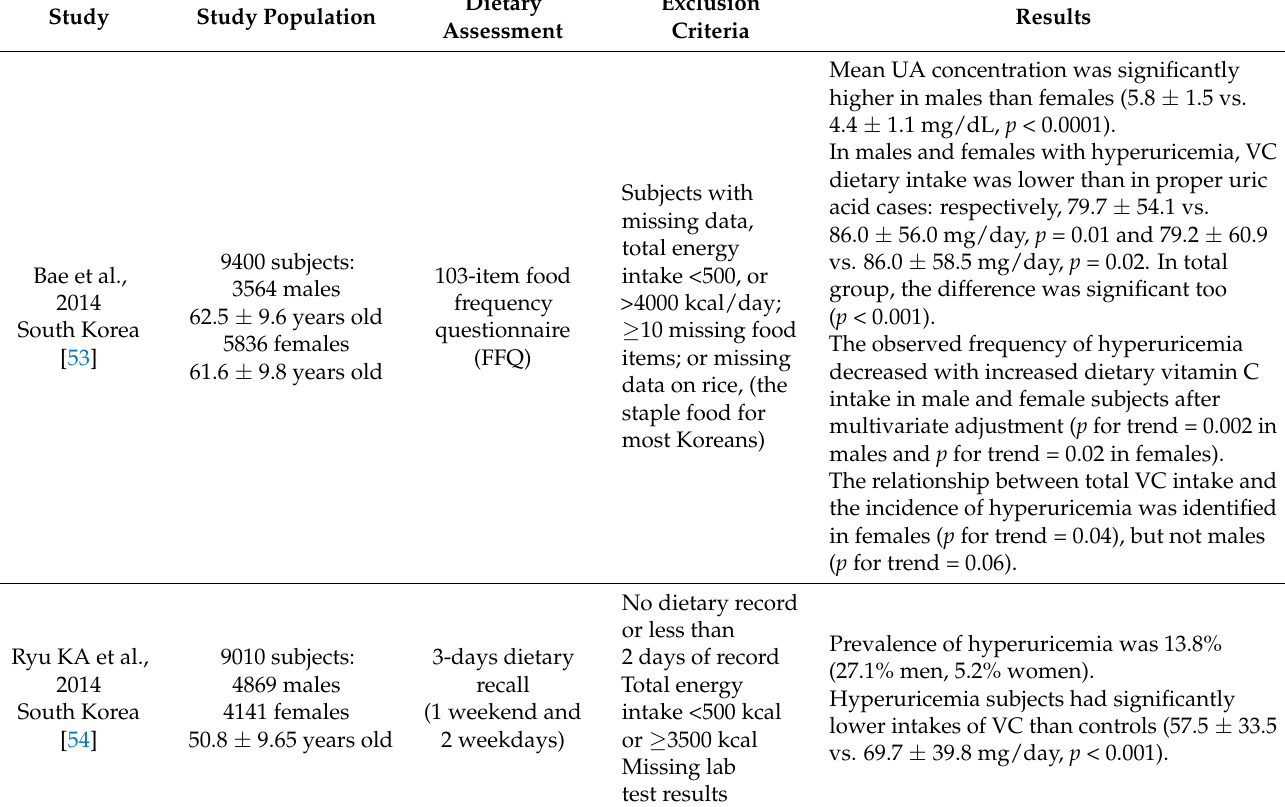
Table 1. Cross-sectional studies discussing the association between vitamin C diet intake and hyperuricemia prevalence. Study Study Population